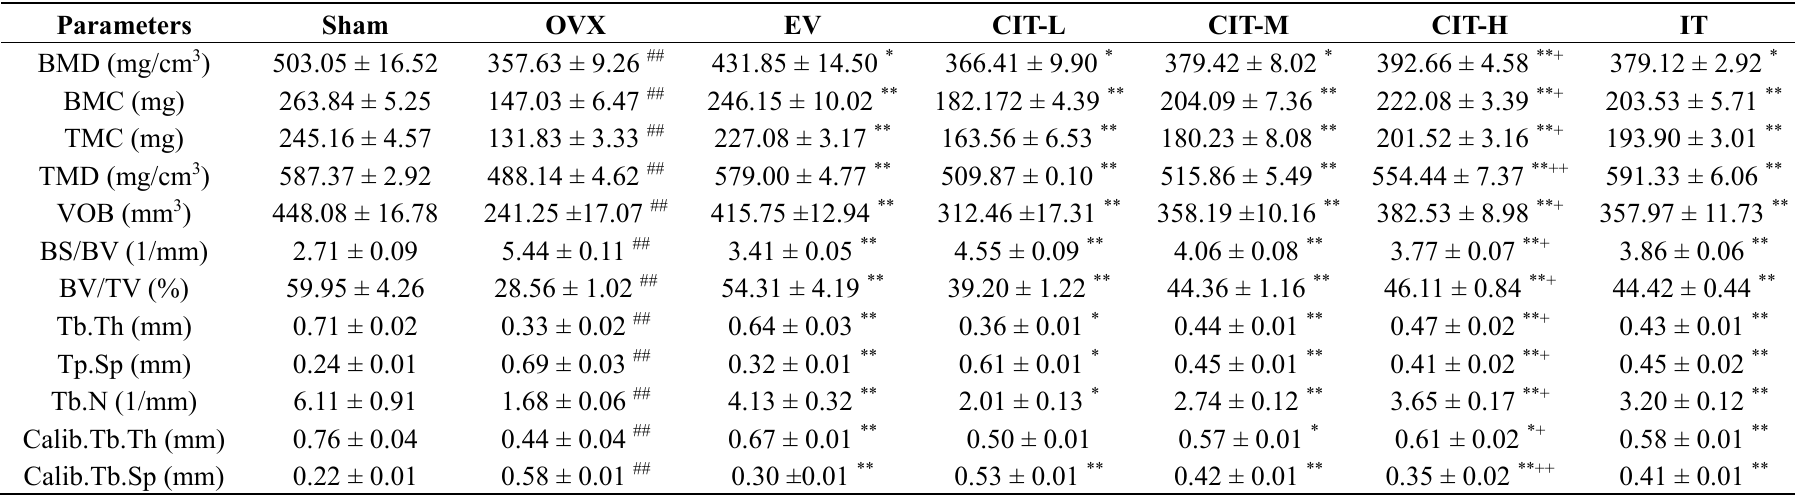
Table 2. BMD and Micro-CT analysis of BMC, TMC, TMD, VOB, BS/BV, BV/TV, Tb.Th, Tb.Sp, Tb.N, Calib.Tb.Th.3D and Calib.Tb.Sp.3D. Parameters